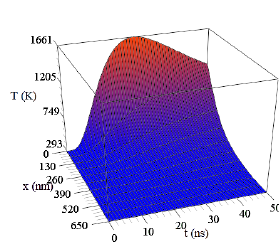
Figure 4. The specific heat follows reasonably well Figure 3. Fitting of the laser profile with a a logarithmic dependence on the temperature (data lognormal dependence on time. t 0 is related from [11]. to the instant at which I ( t ) is maximum and σ is the standard deviation. R 2 is the statistical measure of goodness of fit.